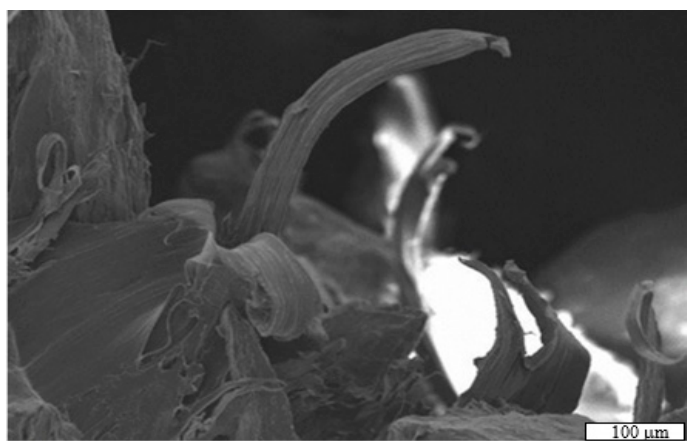
Figure 7. SEM image of the PCL fibers at the fracture face of a tensile test of a 55 wt % DBM/PCL mold sample (the view direction is perpendicular to the XY -plane). Scale bar represents 100 µm.